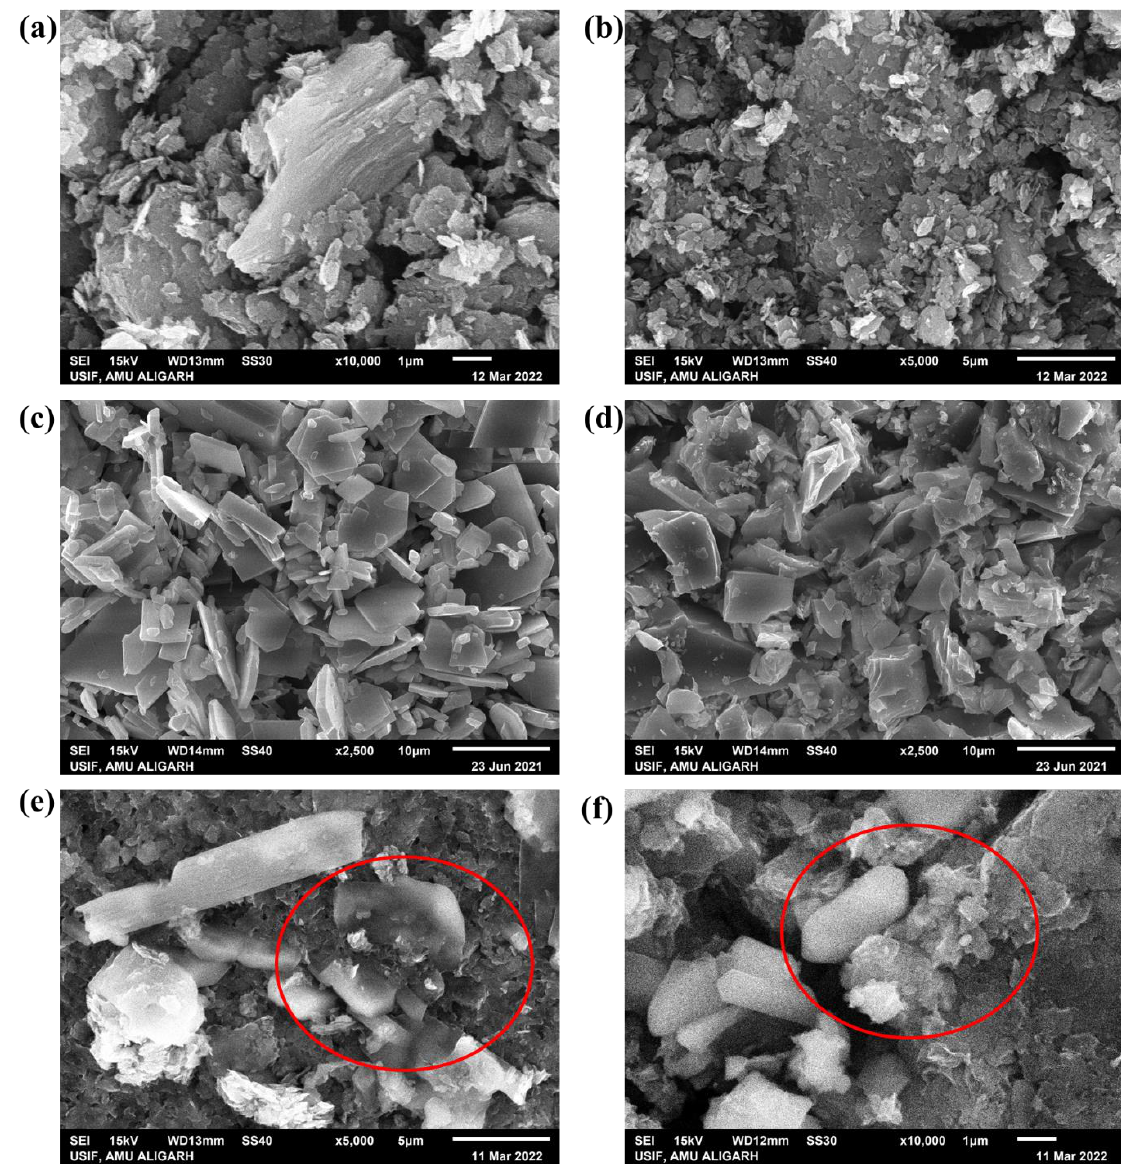
Figure 4. SEM images of GO ( a b ) NCD- 1 ( c ) NCD- 2 ( d ) GO-NCD- 1 ( e ) GO-NCD- 2 ( f) .